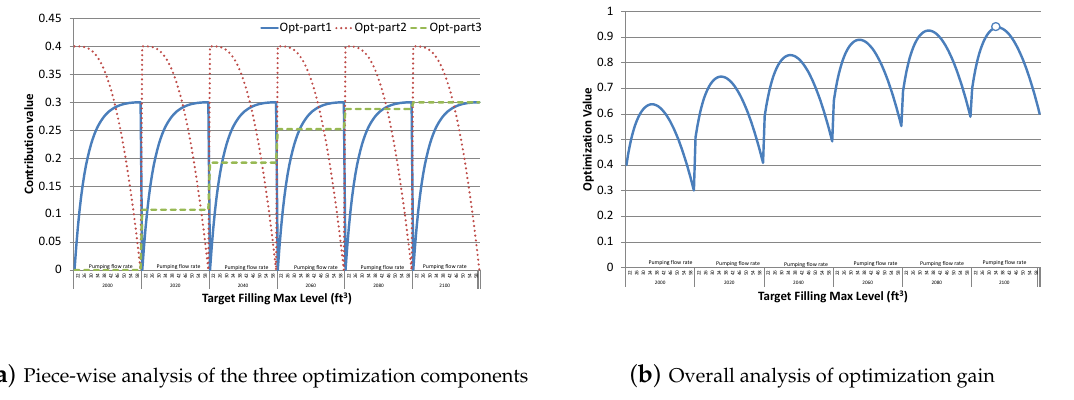
Figure 7. Analysis of revised optimization formula given in Equation